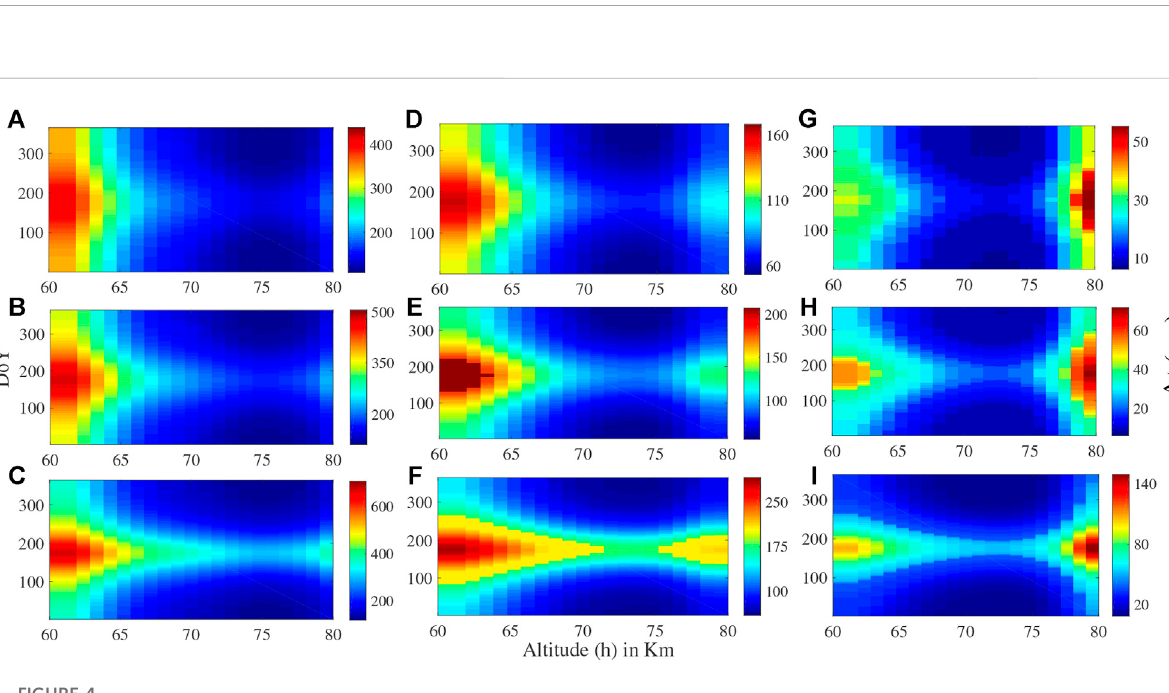
FIGURE 4 Δ t - h pro fi les similar to Figure 3 but for S30 (A,D,G) , S45 (B,E,H) and S60 (C,F,I)